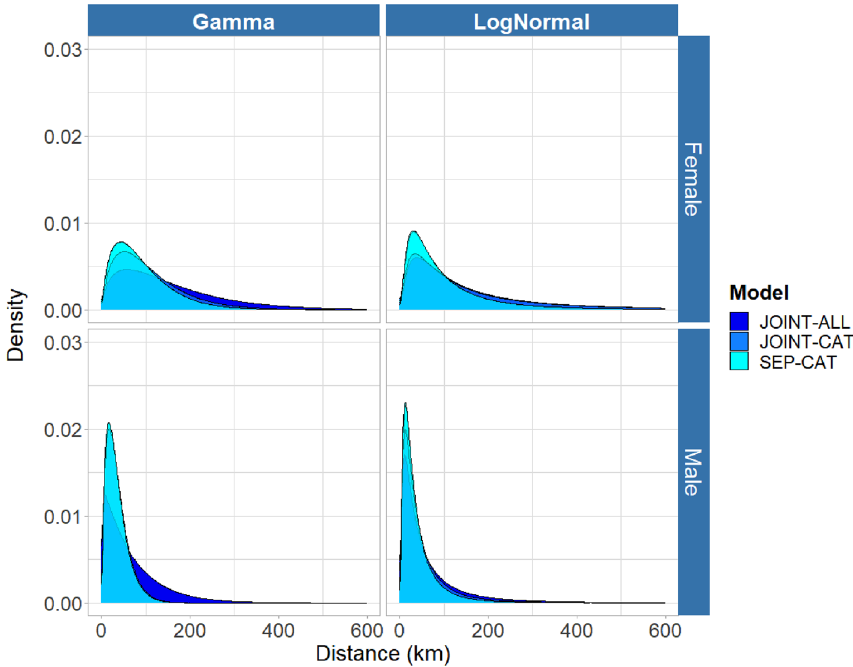
Figure 2. Median natal dispersal kernels (Y: probability density, X: km) by model type, sex, and dispersal distribution.